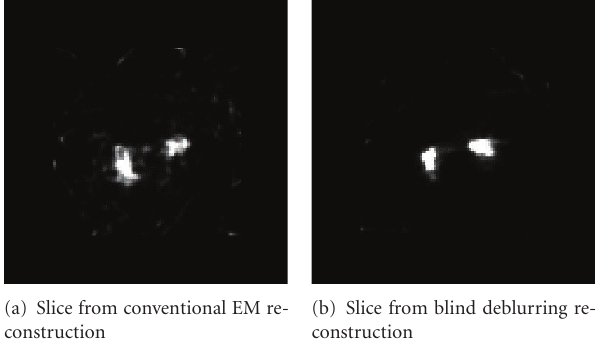
acquisition time was 37 minutes. The ROR was 3.1 cm, and the magnification factor was about